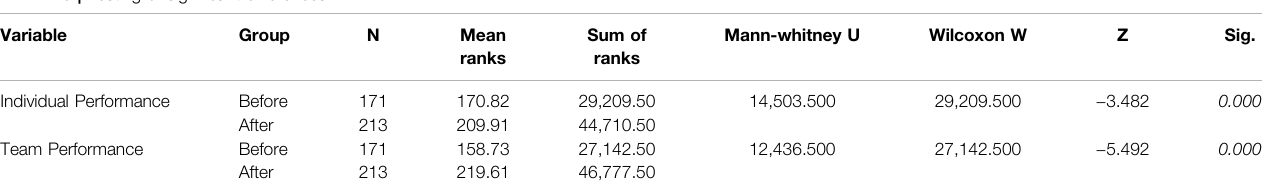
TABLE 3 | Testing of signi fi cant differences.